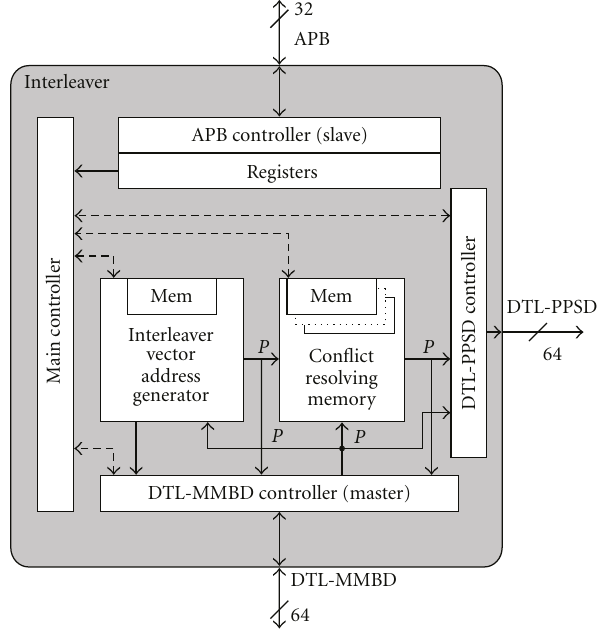
Figure 1: Interleaver architecture Top